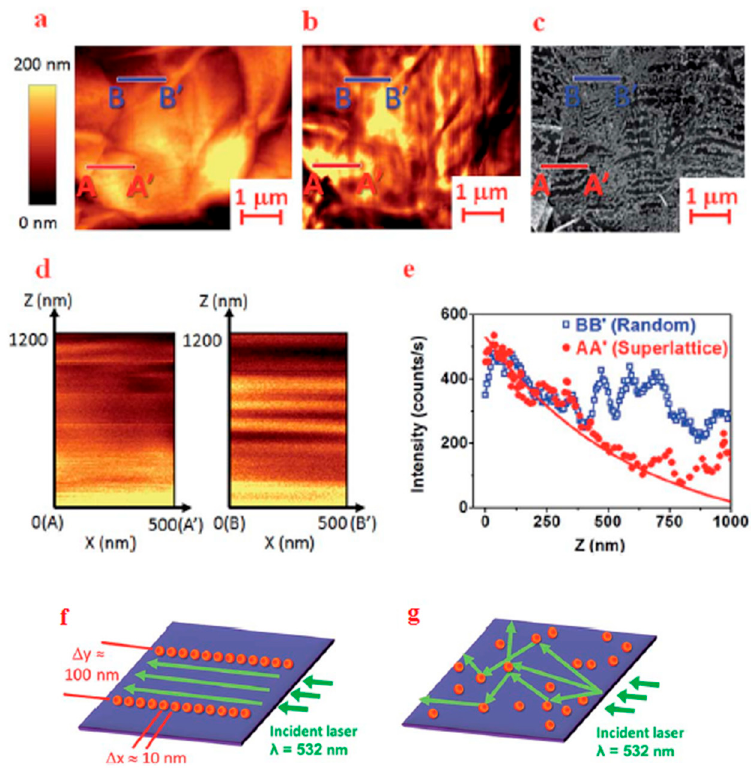
Figure 15. ( a ) AFM, ( b ) c-SNOM, and ( c ) SEM images obtained for the same area of a copper nanoparticle superlattice; ( d ) c-SNOM scans in the z -direction for cross sections A–A’ and B–B’ in panels a–c; ( e ) The integrated intensity shown in panel d identifies the exponential decay of the evanescent wave moving away from the surface along the region A–A’ representing an ordered superlattice. Random interference patterns are observed for the randomly disordered area B–B’; ( f ) Light scattering within the superlattices is coherent as the periodic nanoparticles act as a waveguide; ( g ) Randomly distributed nanoparticles result in incoherent scattering and light absorption. Reproduced with permission from [28], Copyright RSC Advances, 2015.